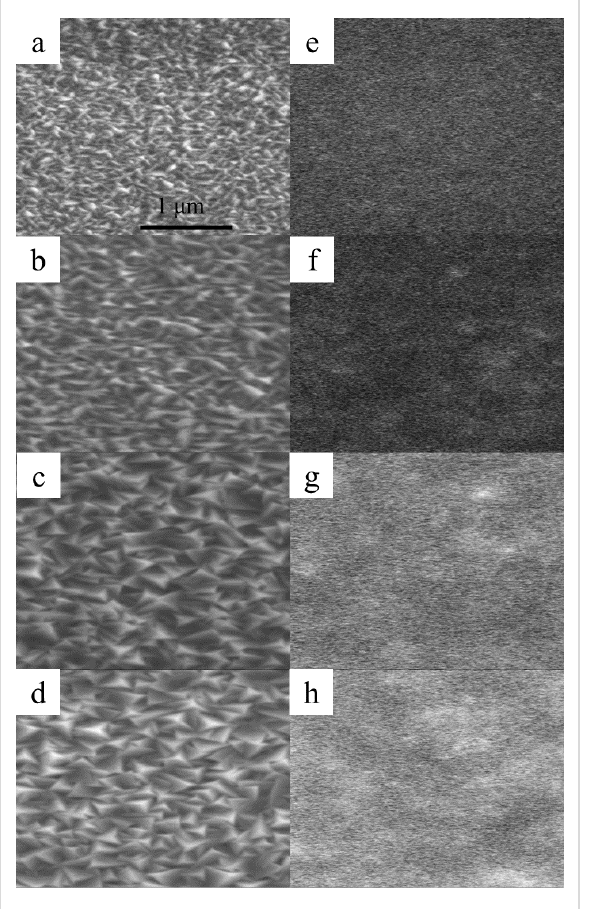
Figure 2: SEM images of the (a) c -20, (b) c -40, (c) c -60, and (d) c -70 ZnO@B samples and the panchromatic CL images (e), (f), (g), and (h), respectively, taken over the same regions with 11 kV excitation elec- tron voltage at RT.